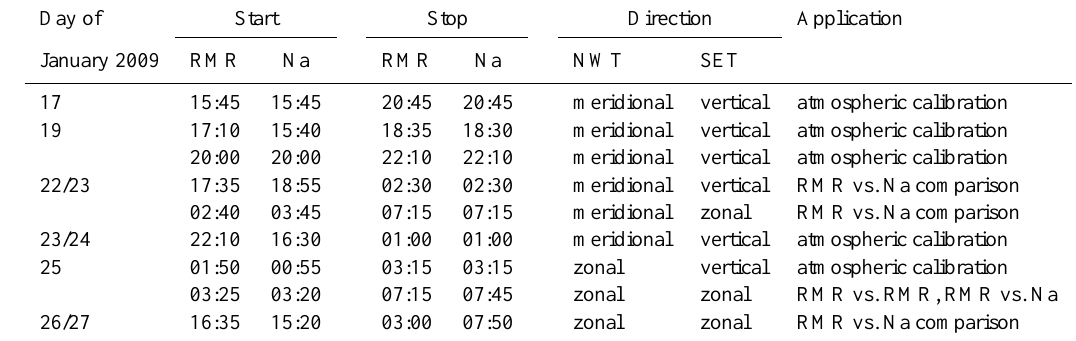
Table 1. Joint observations of RMR lidar and Na lidar in January 2009. Only observations presented in this paper are listed. Day of